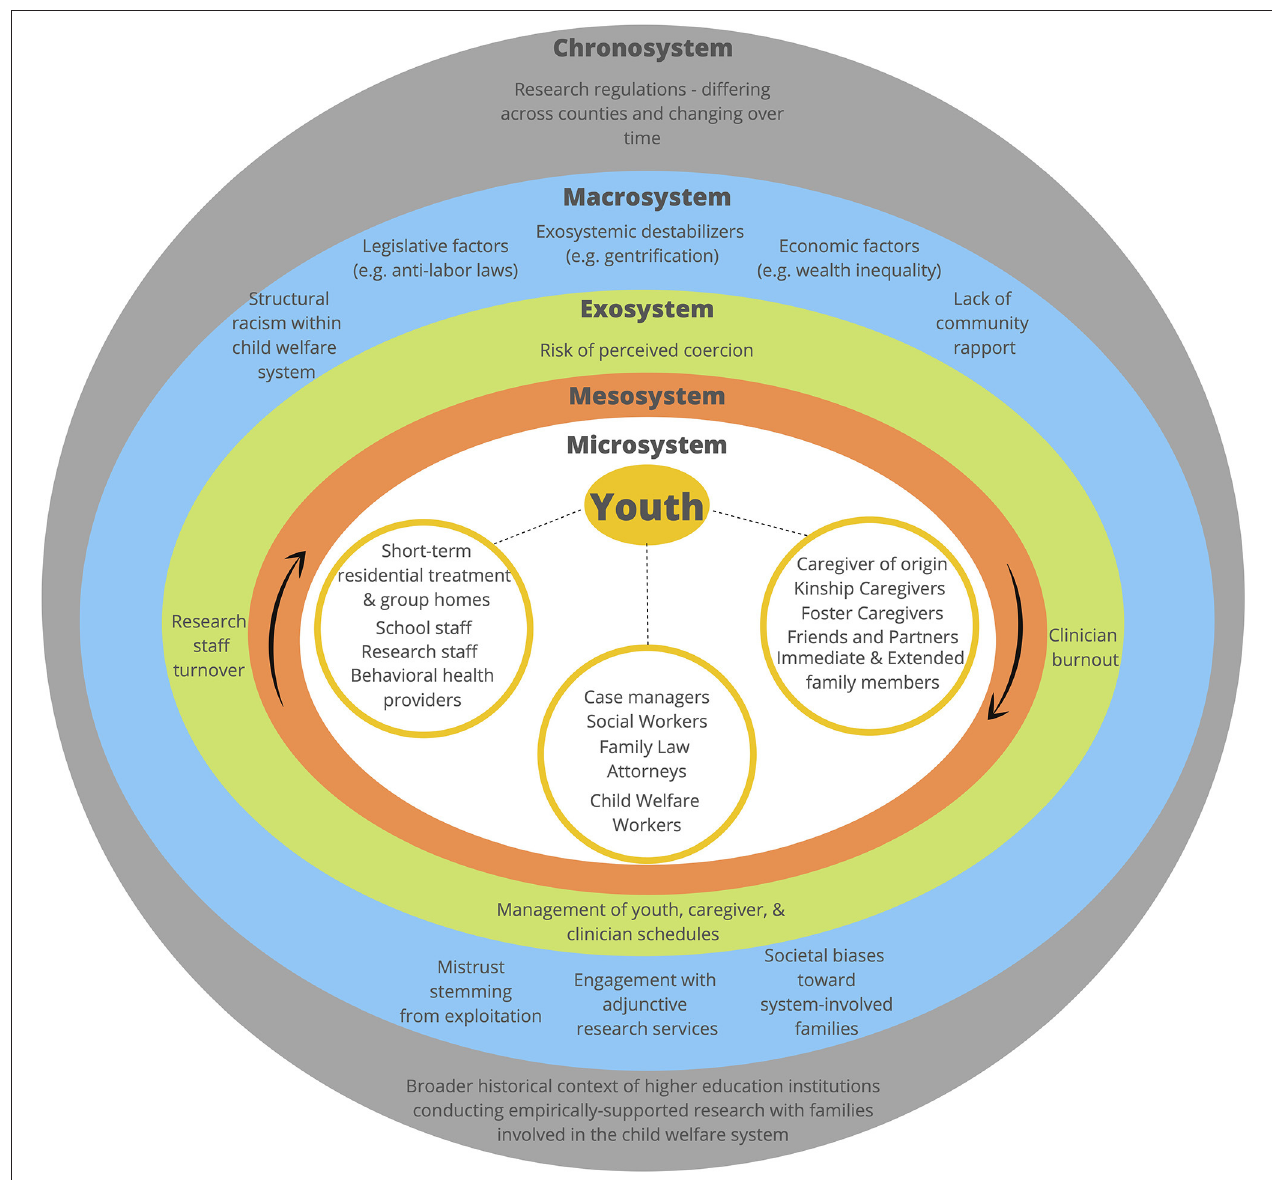
FIGURE 1 | An ecodevelopmental framework for understanding and enhancing engagement in clinical research on family-based telehealth